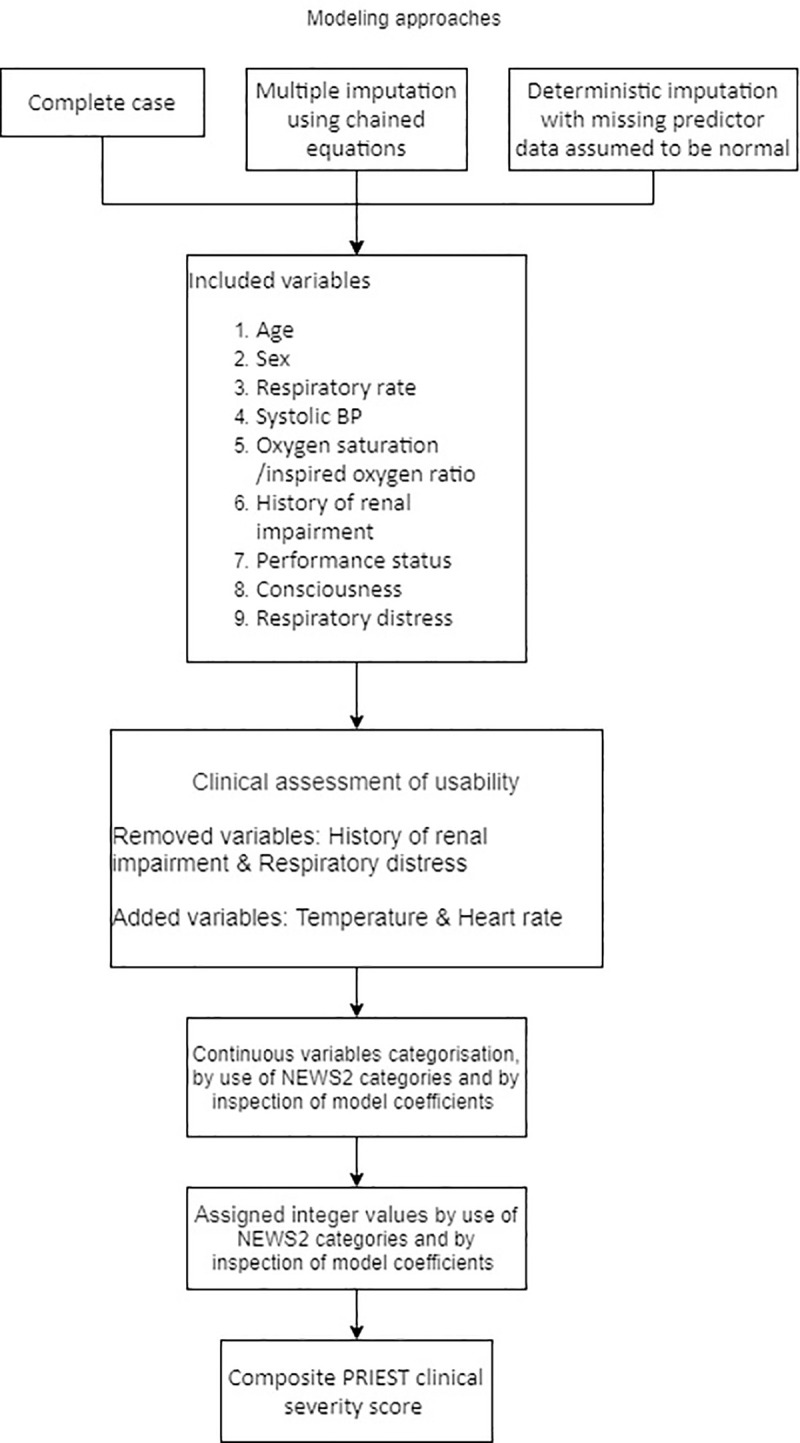
Summary of the derivation process.